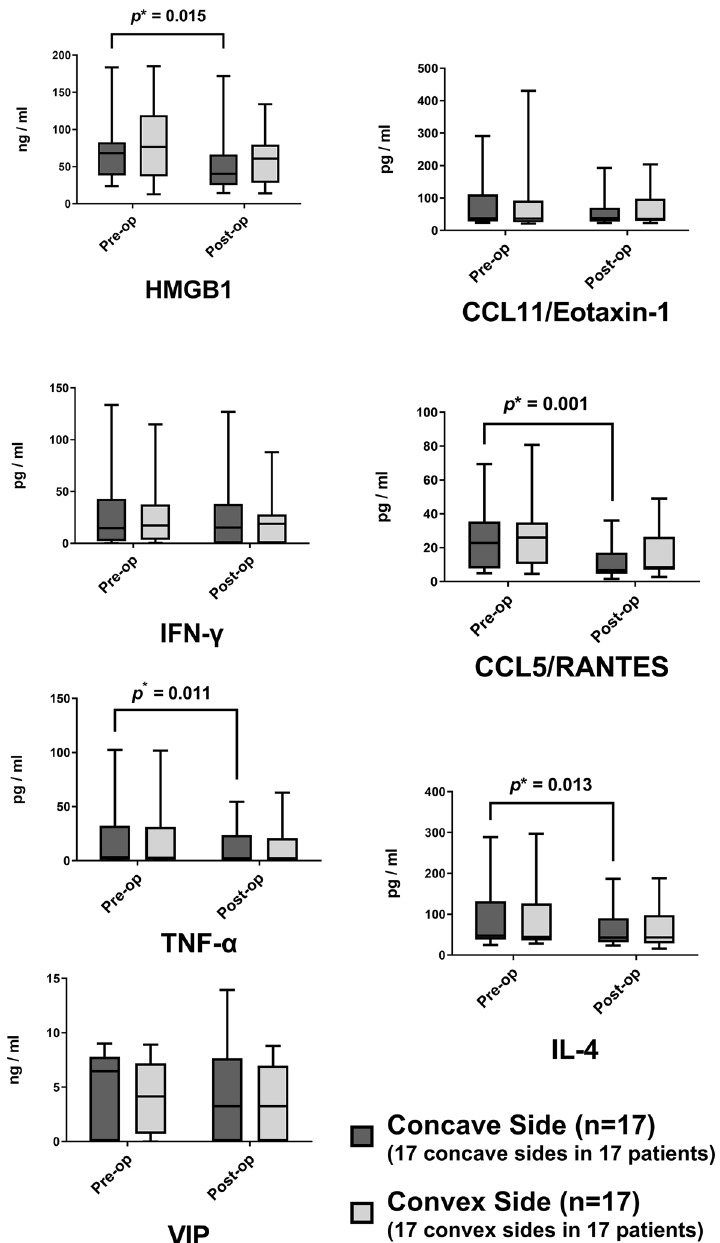
Figure 3. Changes in inflammatory biomarker concentrations in the nasal secretion on the concave and convex sides after septoplasty ( n = 17). Each box indicates the interquartile range; the whiskers indicate the minimum to the maximum value. A Wilcoxon signed-rank test was used to evaluate the significant differences in each cytokine concentration between paired concave and convex nasal cavities. Similarly, the concentration of seven biomarkers in the nasal secretion before and 3 months after septoplasty were paired for all seven biomarkers, and a Wilcoxon signed-rank test was used to evaluate the significant differences between the pre- and postoperative state. Upper asterisk indicates statistical significance ( p value <